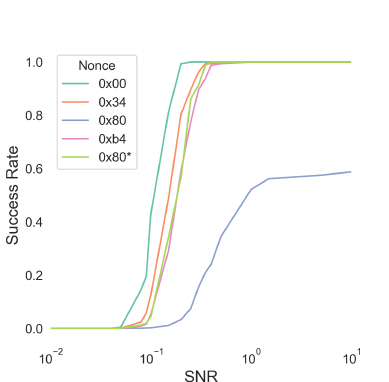
Figure 16: Success Rates of the attack for various nonces with 256 traces (except 0x80 ∗ with 128 traces).